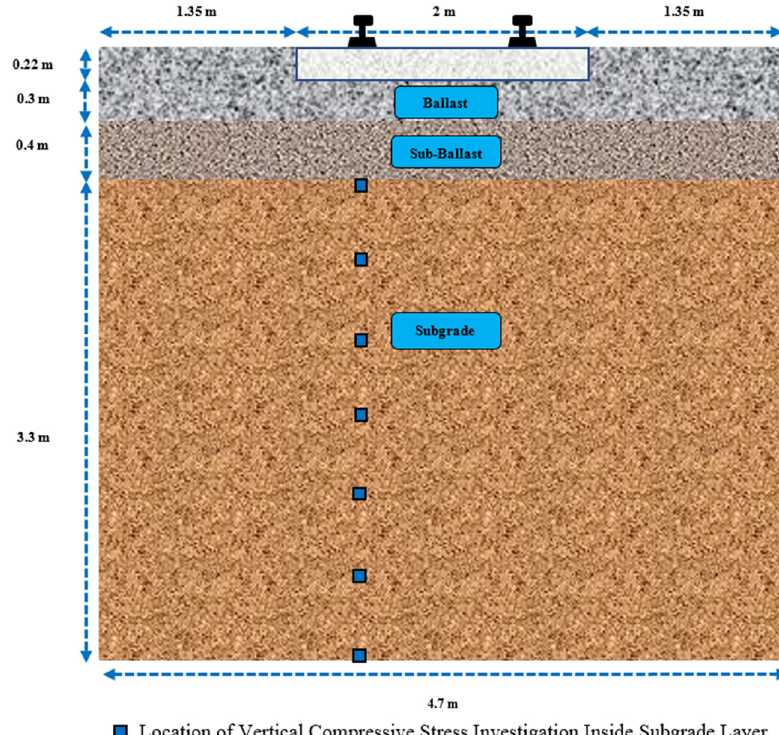
Figure 1: Indonesian ’ s ballasted track geometric for numerical